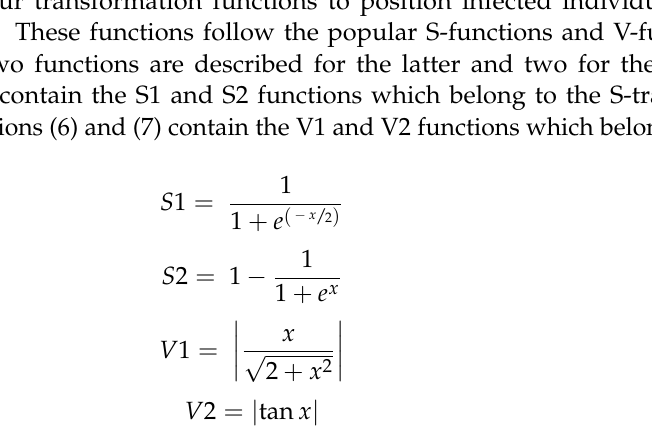
Figure 2. Identification of selected features as obtainable in every instance of the entire dataset.